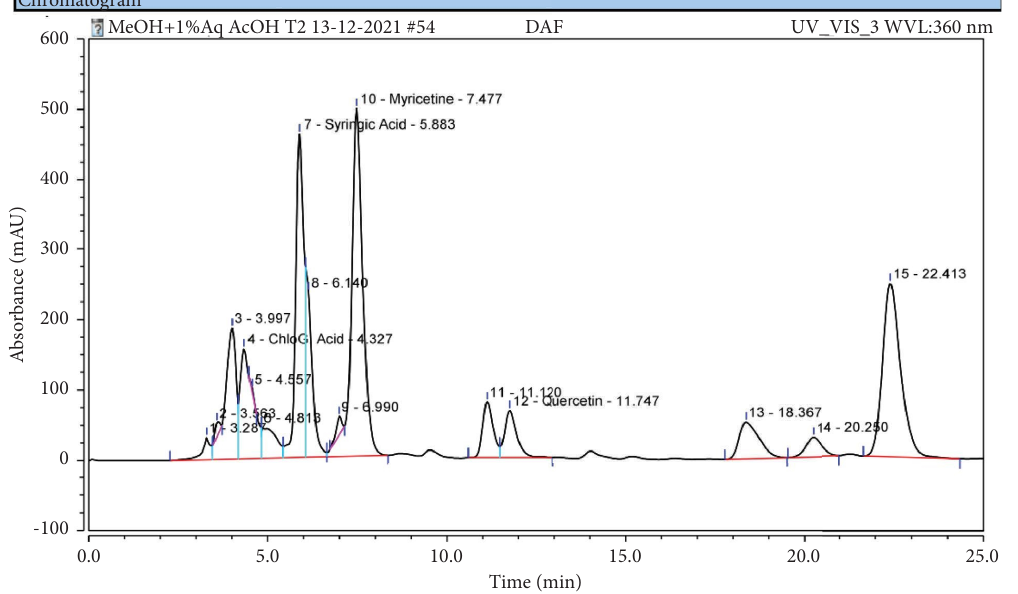
Figure 1: UHPLC-DAD chromatogram for the methanol extract of D. angustifolia fower. Table 3: HPLC data table for the identifed components of D. angustifolia